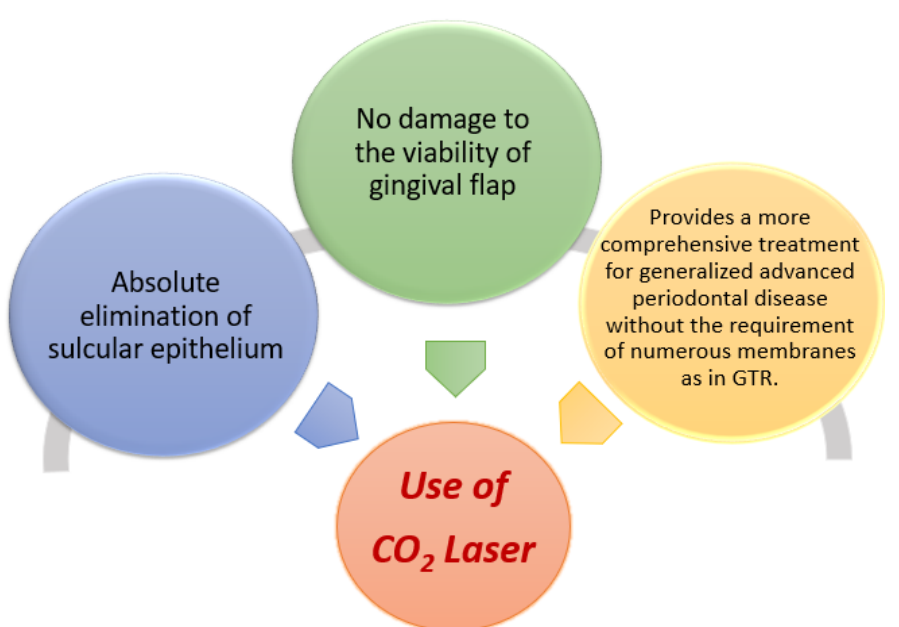
Figure 12. Advantages of laser in periodontal therapy in contrast to conventional periodontal surgeries.